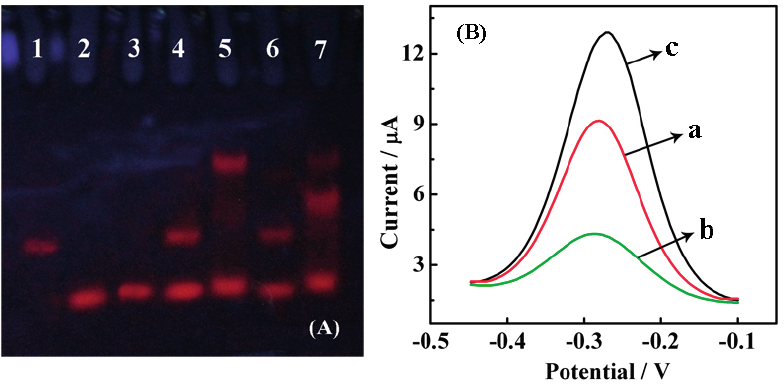
Figure 2. Verification of Nt.BbvCI-assisted catalyzed TRA. ( A ) Polyacrylamide